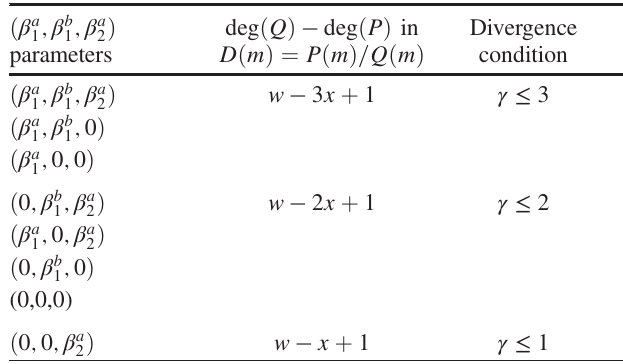
TABLE VI. Divergence conditions for 1. Case 2: Totally correlated scale-free layers P ð k; l Þ ¼ C